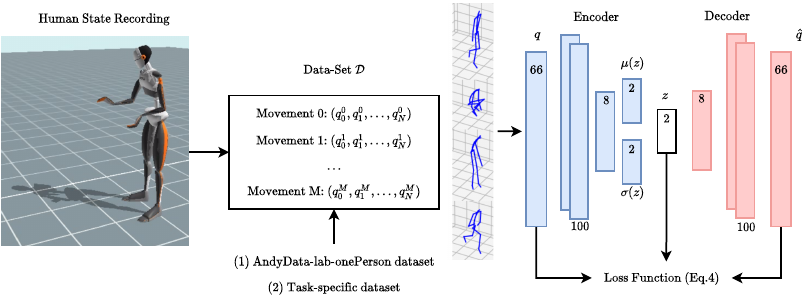
Figure 3. Training the VAE of the LEM requires a dataset of human postures. For each posture an ergonomics score exists. In our experiments, as a dataset, we used: (1) the AnDy dataset [30] and (2) a task-specific dataset acquired for each experiment. The training is done to find the VAE weights which simultaneously minimize the reconstruction error of the postures and the associated ergonomics